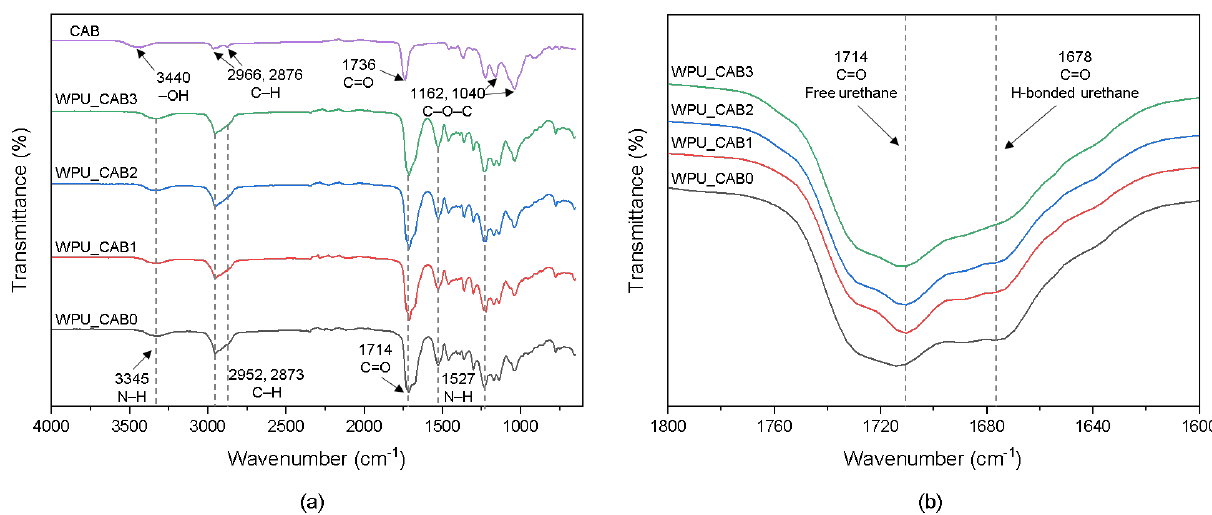
Figure 2. FTIR spectra ( a ) in the overall frequency range and ( b ) in the C=O stretching region of WPU films with different CAB contents.